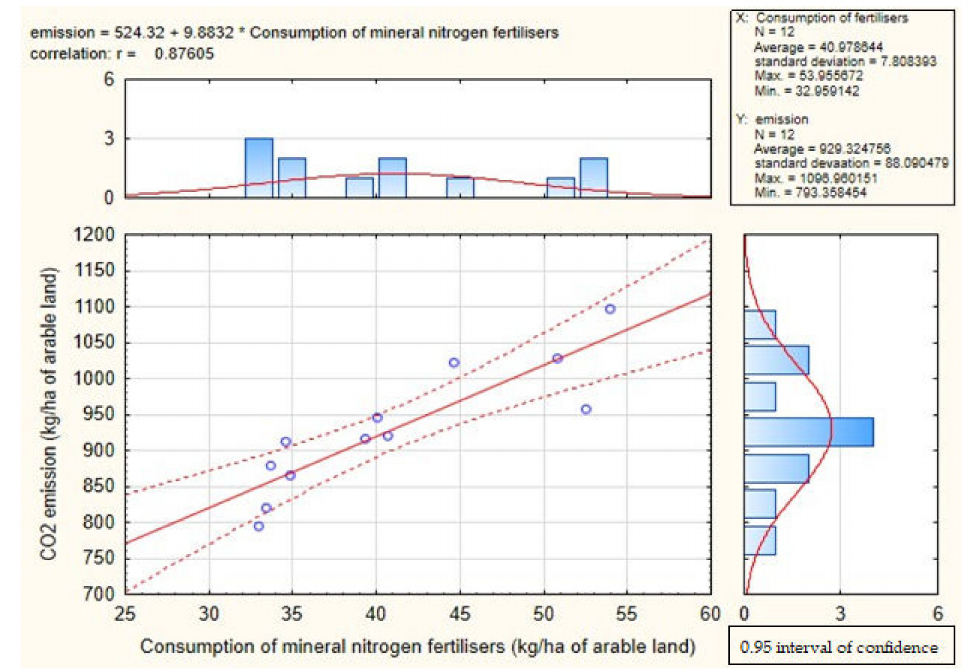
Figure A1. Results of correlations analysis: Romania. Source: own calculation based on Eurostat. Note: purple dot: observation, red solid line: linear function, red dashed lines: 95% interval of